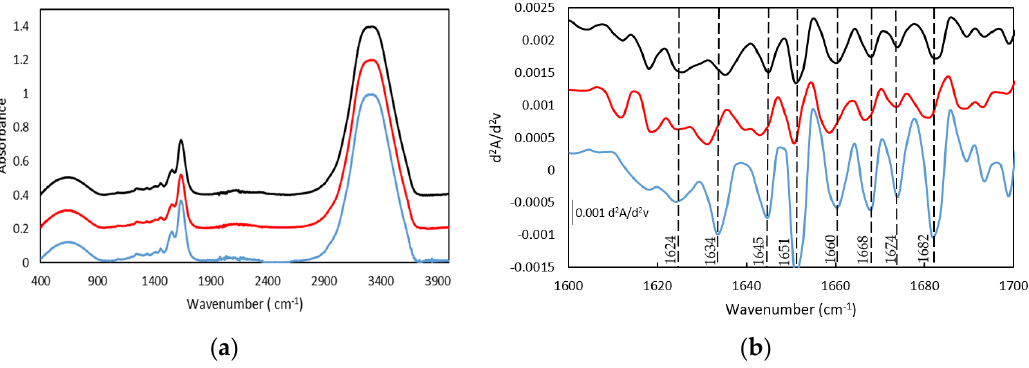
Figure 5. FTIR spectra ( a ) and Spectra of the second derivative (differential FTIR spectra) in the absorption region of amide I by FDD method ( b ), of ( - ) 25GE, ( - ) 25GE/DOX and ( - ) 25GE/Crocin. Table 5. Assignments of IR bands to the secondary structure of Dry GE, 25GE, 25GE/DOX and 25GE/Crocin.